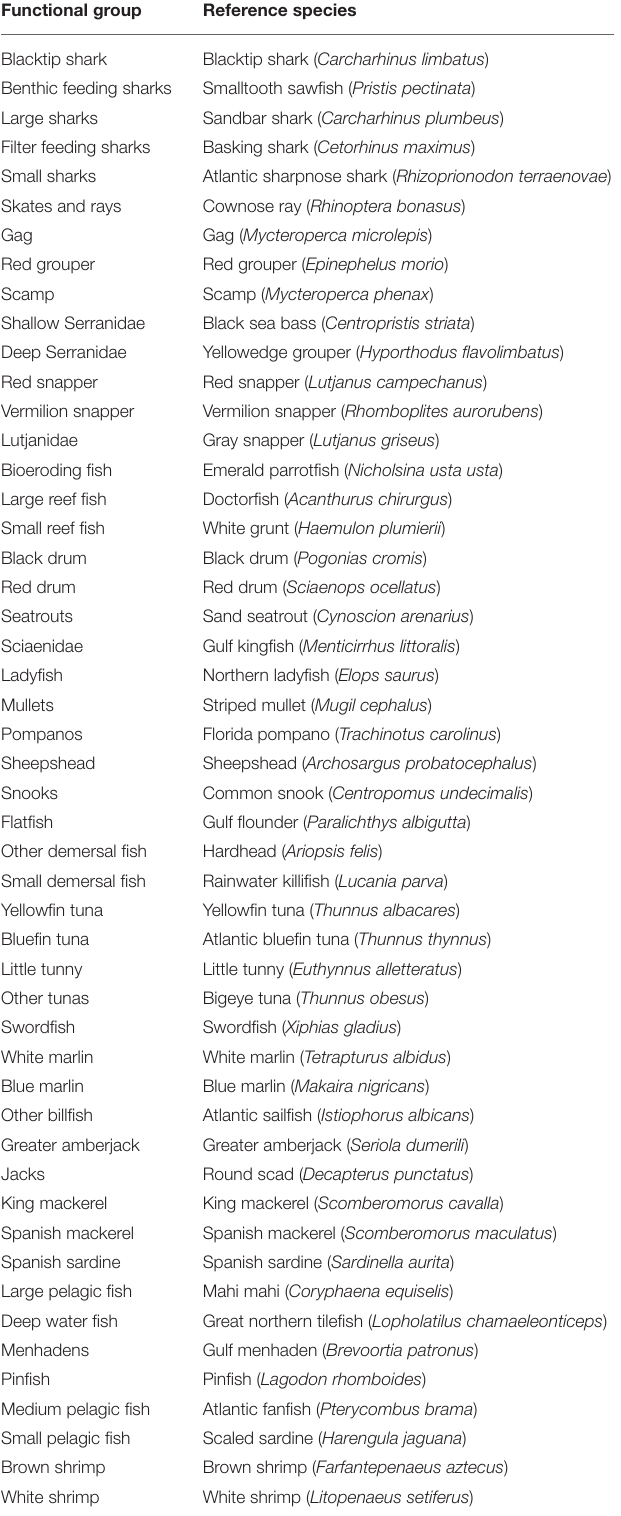
TABLE 1 | Fish and invertebrate functional groups represented in the Atlantis-GOM ecosystem model. Functional group Reference species Blacktip